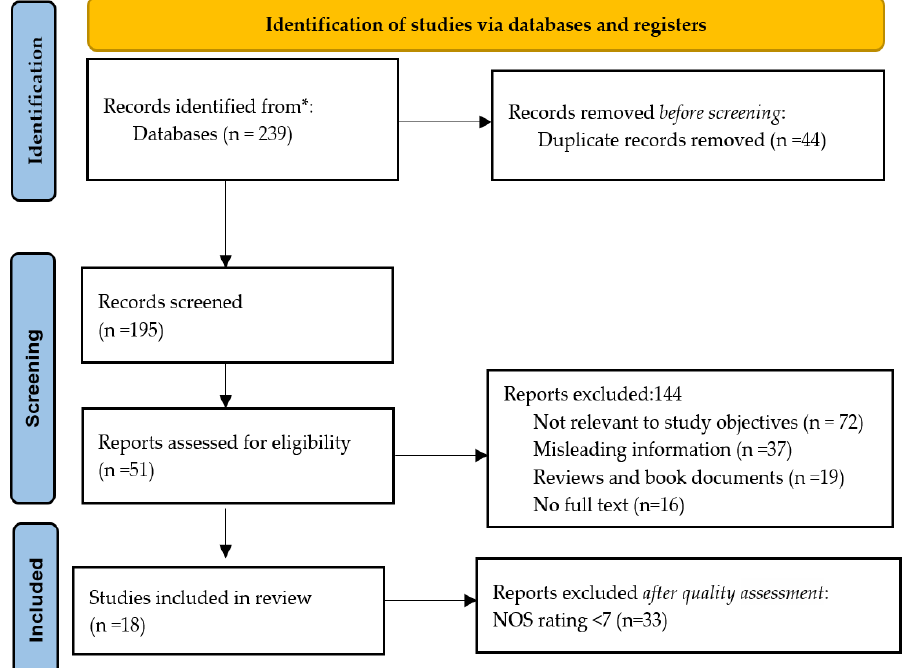
Figure 2. PRISMA 2020 flowchart representation for new systematic reviews, including searches of databases (* selected libraries) [30].